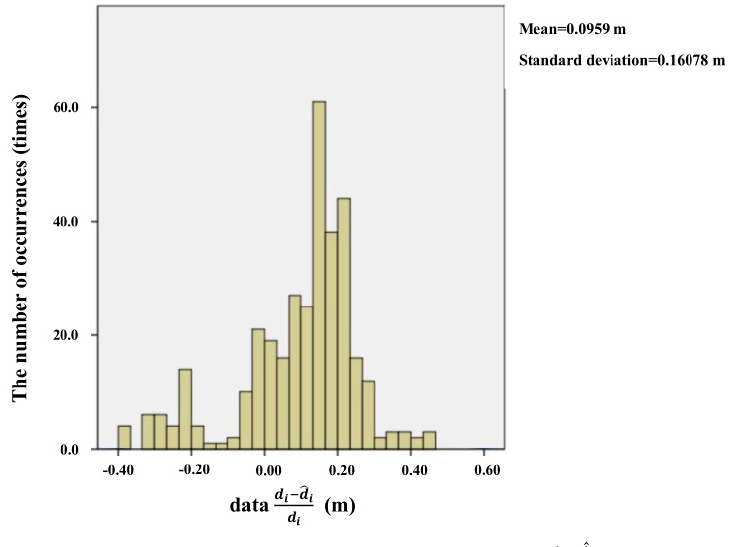
ˆ d i . (cid:2879)(cid:3031)(cid:3552) (cid:3284) d i . (cid:3031) (cid:3284) (cid:2879)(cid:3031)(cid:3552) (cid:3284) . (cid:3031) (cid:3284)